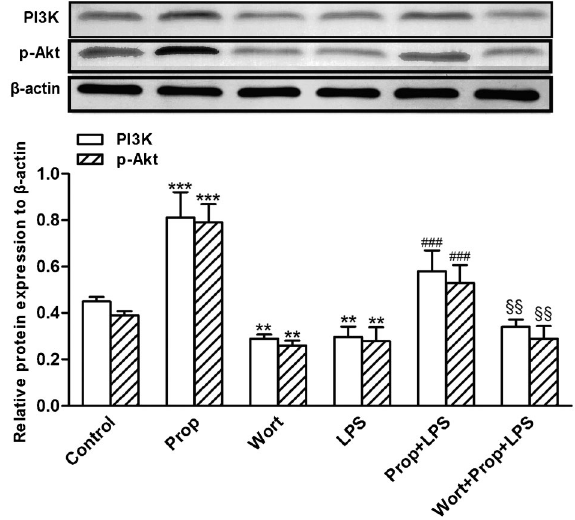
Figure 4. Phosphoinositide-3-kinase (PI3K) and p-Akt protein in rat lung. Top , Representative Western blots are shown with the PI3/K, p-Akt and b -actin labeled band. Bottom , Densitometry of all Western blot results from rat lungs of the 6 groups. Data are reported as means±SD for n=6 animals per group. LPS: lipopolysaccharide; Prop: propofol; Wort: wortmannin. **P , 0.01, ***P , 0.001 compared to the control group; ### P , 0.001 compared to the LPS group; 11 P , 0.01 compared to the Prop++LPS group (Tukey multiple comparison